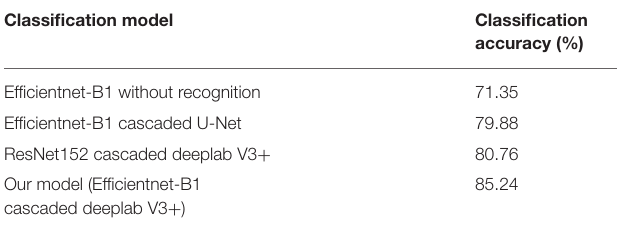
TABLE 3 | Results of subtype classification of superficial perivascular dermatitis.